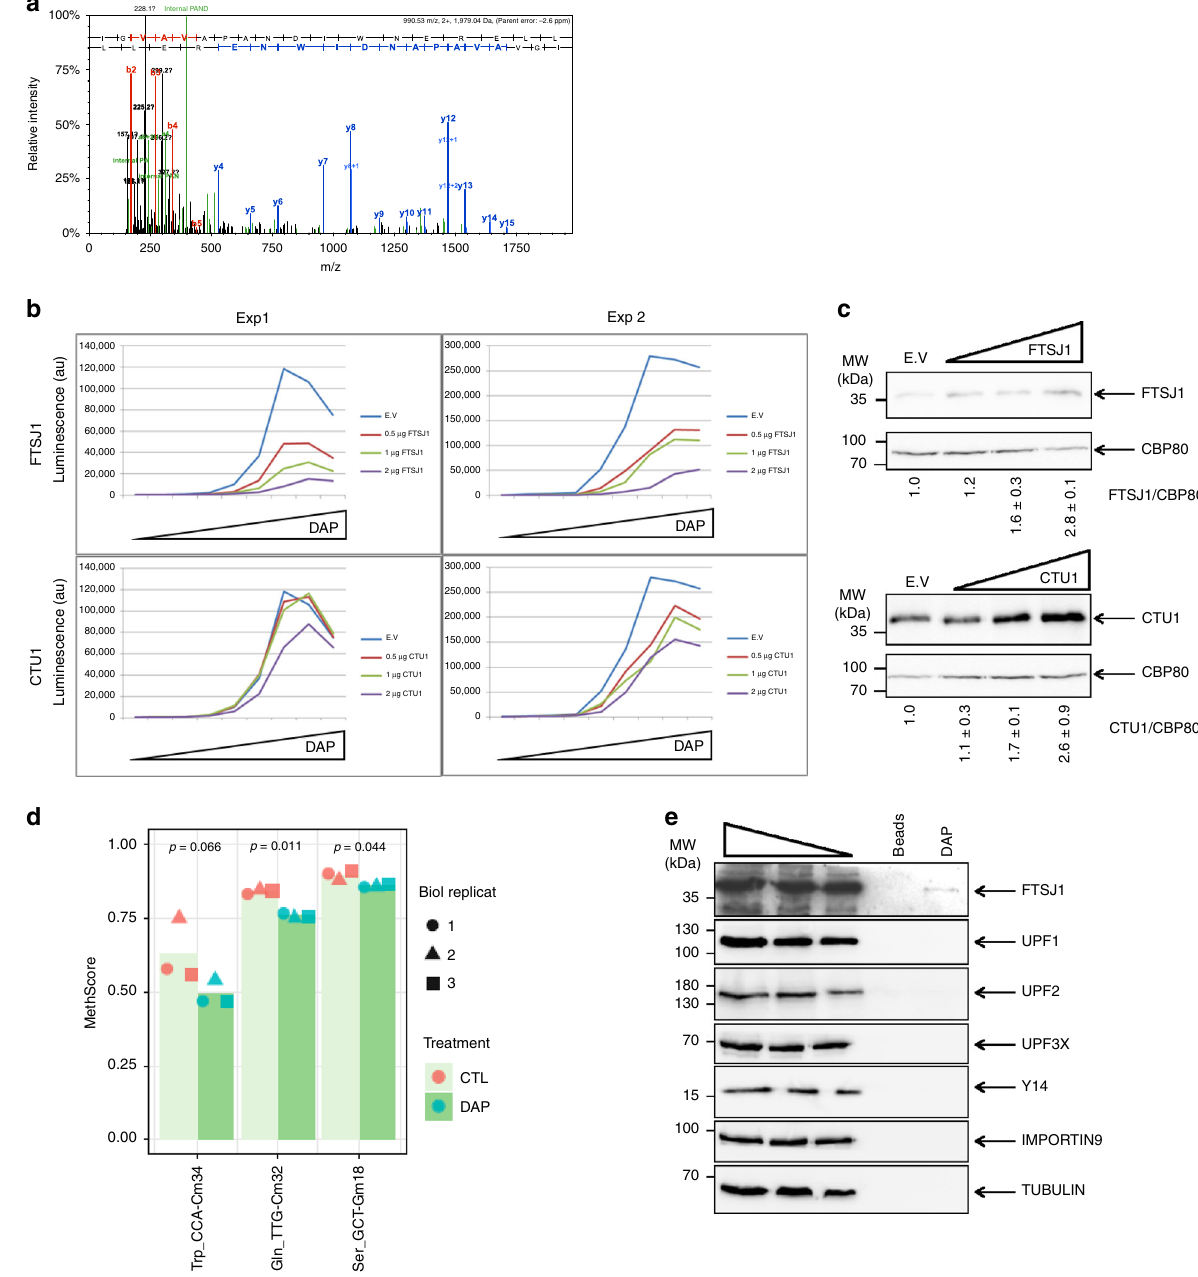
Fig. 5 DAP interferes with the activity of FTSJ1. a Determination by tandem mass spectrometry of the amino acid incorporated at the PTC position. Fire fl y luciferase from HEK293FT cells transfected with the Fluc-int-UGA construct was immunoprecipitated and digested with trypsin. The MS/MS spectrum of the peptide containing the PTC position and the sequence determination are shown. The upper red and blue sequences indicate the amino acids validated, respectively, by detection of Nter and Cter peptide fragments (b and y ion series). Peptide fragments y6 and y7 clearly identify tryptophan (W) at the PTC position. The black peaks correspond to non-attributed mass-to-charge ratio (m/z) values. The green peaks are internal fragments that do not contain an extremity of the peptide. b The ef fi ciency of UGA readthrough by DAP decreases with increasing amounts of FTSJ1 but not with increasing amounts of CTU1. Readthrough ef fi ciency was determined by measuring luciferase activity in HeLa cells co-transfected with the fi re fl y luciferase construct described in Fig. 1b and with increasing amounts of an expression vector for either FTSJ1 or CTU1 (0.5, 1, or 2 µ g). The empty expression vector (E.v.) was used as control. The cells were then exposed to 0, 0.39, 0.78, 1.56, 6.25, 25, 100, 300, or 600 µ M DAP for 24 h before measuring the luciferase activity. The experiment was performed twice and the results of both experiments (Exp1 and Exp2) are shown. c Western blot analysis of FTSJ1 and CTU1. d 2 ′ -O- methylation analysis of tRNA Trp , tRNA SER , and tRNA GLN by RiboMethSeq. HeLa cells were incubated for 24 h with DMSO or with 25 µ M DAP. A MethScore was attributed to each tRNA 2 ′ -O-methylation in tRNA puri fi ed from HeLa cells treated with DAP (dark green histogram) or DMSO (light green histogram). The results of three independent experiments are indicated with the symbols square, point, or triangle. e Analysis of DAP af fi nity column eluates shows that DAP interacts with FTSJ1. HeLa-cell extract was incubated with DAP covalently bound to beads or with beads alone. Proteins bound to the columns were eluted with excess DAP and the eluates analyzed by western blotting. A molecular weight marker is indicated to the left of each gel. p -values ( p ) were calculated using Student ’ s t -test. Source data are provided as a Source Data fi